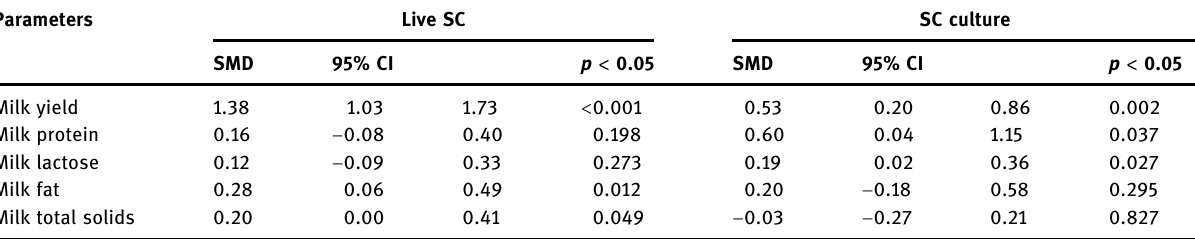
Table 4: Subgroup analysis of the e ff ect of SC type on milk yield and components in small ruminants